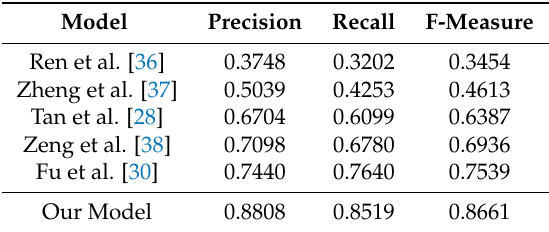
Table 5. Comparison of results on the test